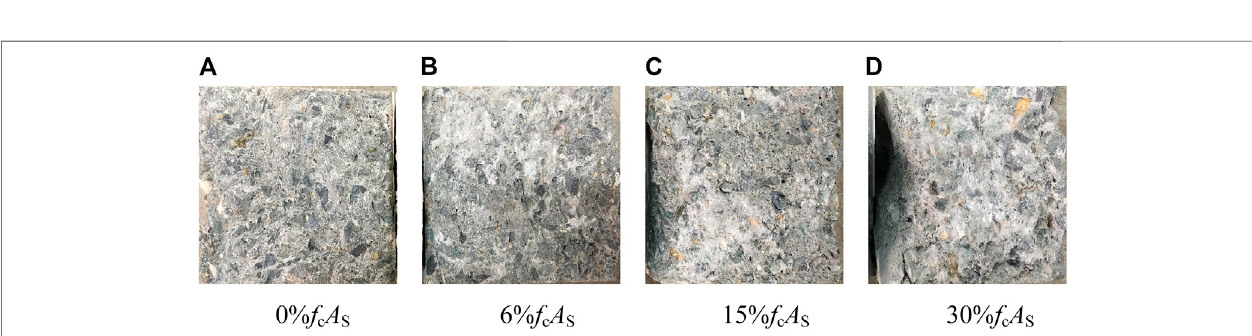
FIGURE 6 | Failure modes on the shear failure section of SCC under different axial loads. (A) 0%fcAS. (B) 6%fcAS. (C) 15%fcAS. (D) 30%fcAS.